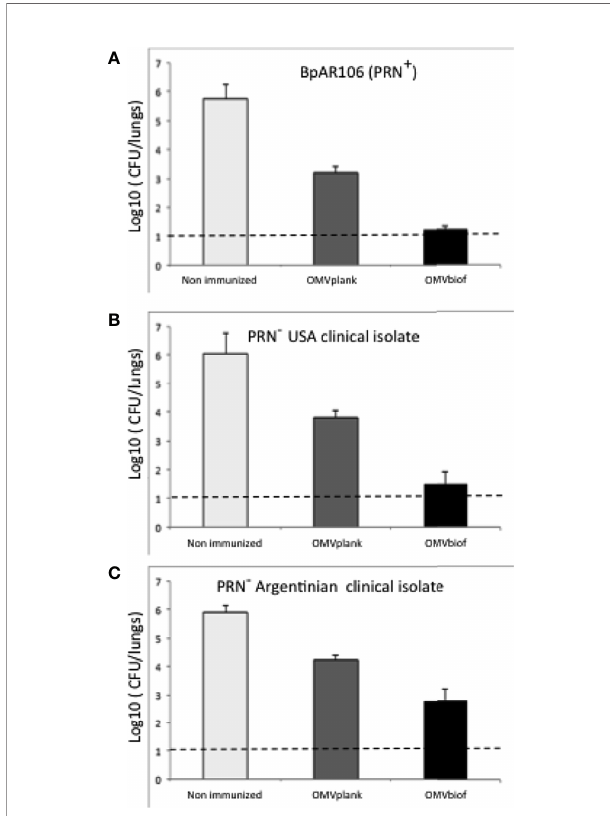
FIGURE 6 | Protection against B . pertussis PRN(-) isolates induced with OMVbiof- or OMVplank-based vaccines in a mouse model. BALB/c mice were immunized (i.m) twice, 2 weeks apart. Mice were challenged with sublethal doses (5 x 10 7 CFU/40 m l) of B . pertussis BpAR106 PRN(+) (A) , USA PRN(-) B . pertussis clinical isolate (B) or Argentinian PRN(-) B. pertussis clinical isolate (C) , 2 weeks after the second immunization with OMV-based vaccine. Non-immunized animals were included as negative control of protection. Three independent experiments were performed for each strain/isolate. Results from one representative experiment are shown. Results depicted are means of 5 mice per group sacri fi ced at 7 days post- challenge. The dashed line indicates the lower limit of detection. The number of bacteria recovered from mouse lungs is expressed as the average log 10 CFU ± SEM (error bars) per lung. Data obtained were analyzed statistically by using one-way analysis of variance (ANOVA) followed by Bonferroni´s multiple comparison test (GraphPadPrism ® ). For panel (A) signi fi cant differences among the treatments with p < 0.001 were detected. For panels (B, C) signi fi cant differences among the treatments with p < 0.05 were